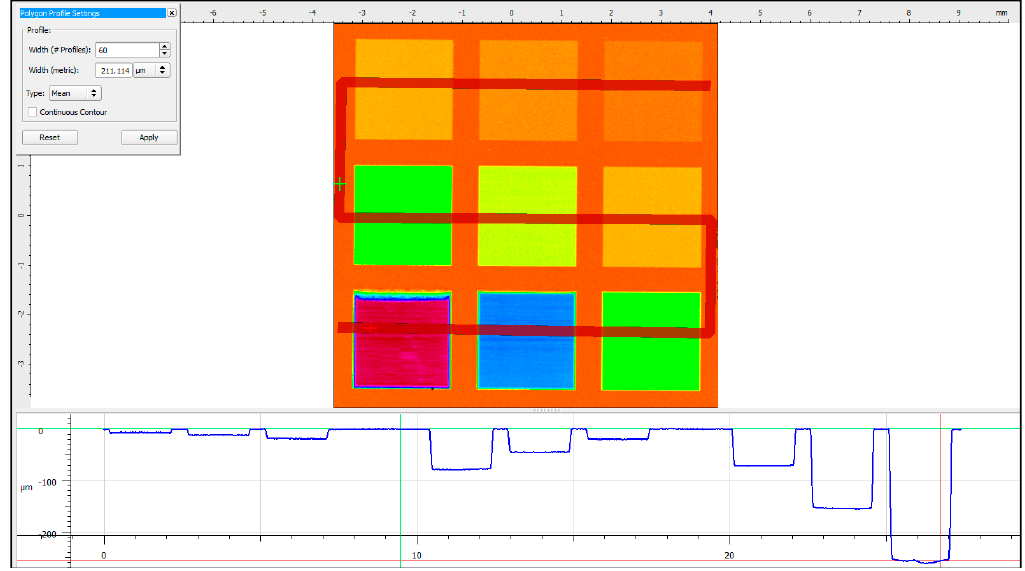
Figure 6. Surface profile of the optimisation samples.